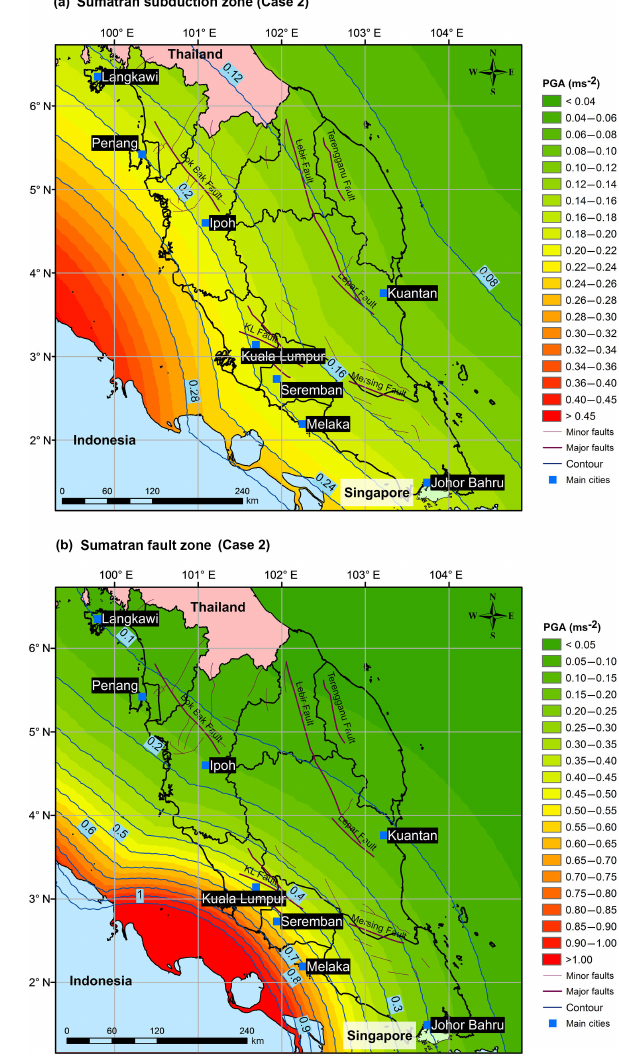
Figure 9. PGA maps of Peninsular Malaysia obtained using DSHA. (a) Case 1 – mean GMPE, (b) Case 2 as “critical-worst” case – mean GMPE plus standard deviation.